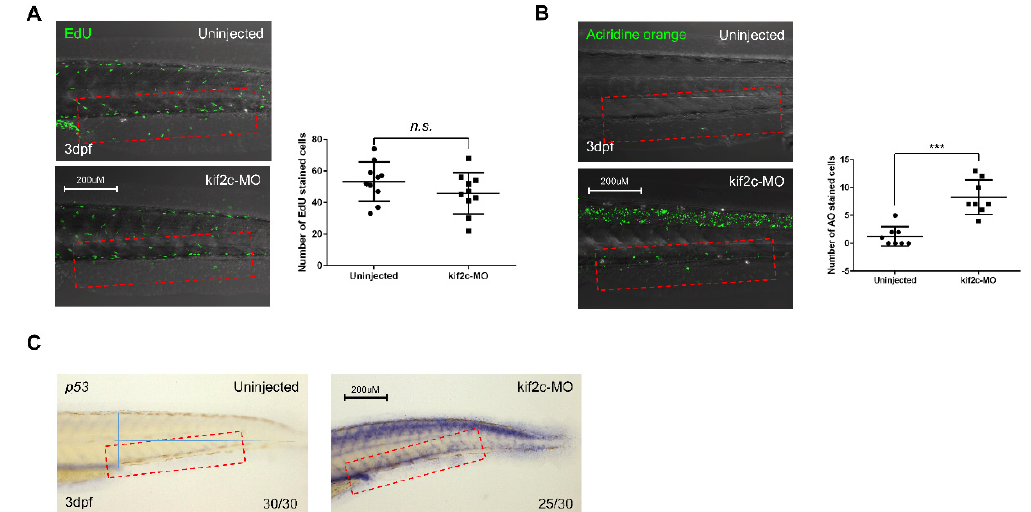
Figure 6. kif2c is important for survival of hematopoietic stem cells through regulation of DNA damage. ( A ) Lateral view of caudal hematopoietic tissue (CHT) using confocal microscope. Confocal imaging of 5-ethynyl-2’deoxyuridine (EdU)-stained control and kif2c -targeting morpholino-injected embryos. Right panel shows quantified data ( n.s. indicates significance at p value > 0.05). Red frames indicate caudal hematopoietic tissue. ( B ) Apoptosis was observed by Acridine orange (AO) staining of control and kif2c -targeting morpholino-injected embryos. Right panel shows quantified data (*** indicates significance at p value < 0.001). Red frames indicate caudal hematopoietic tissue. ( C ) Whole-mount in situ hybridization uninjected embryos and kif2c -targeting morpholino-injected embryos at 3 days post fertilization (dpf) using p53 probe. Red frames indicate caudal hematopoietic tissue.